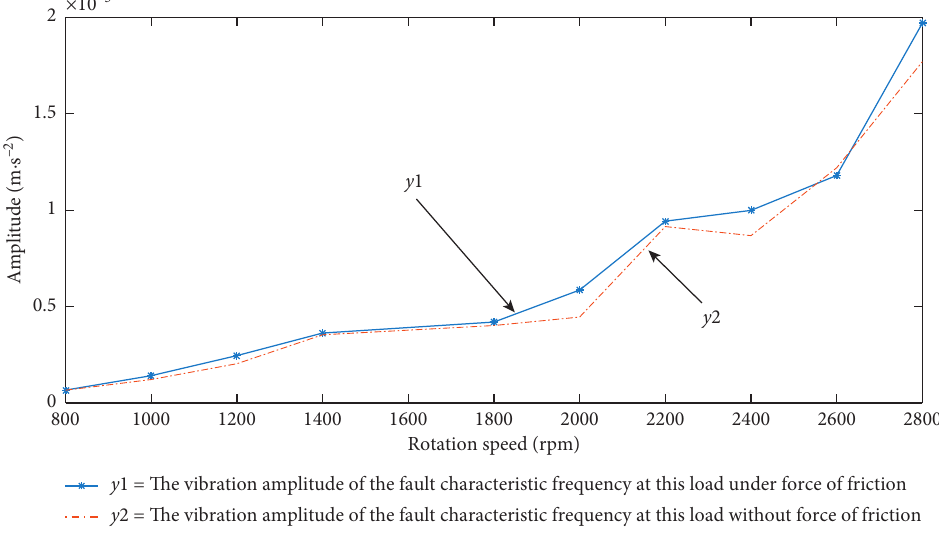
Figure 24: Simulated signals in frequency domain under different rotation speeds with sliding when load is 1500N, F is 0.014 inches: (a) 1800rpm, (b) 2000rpm, (c) 2200rpm, and (d) 2400rpm.